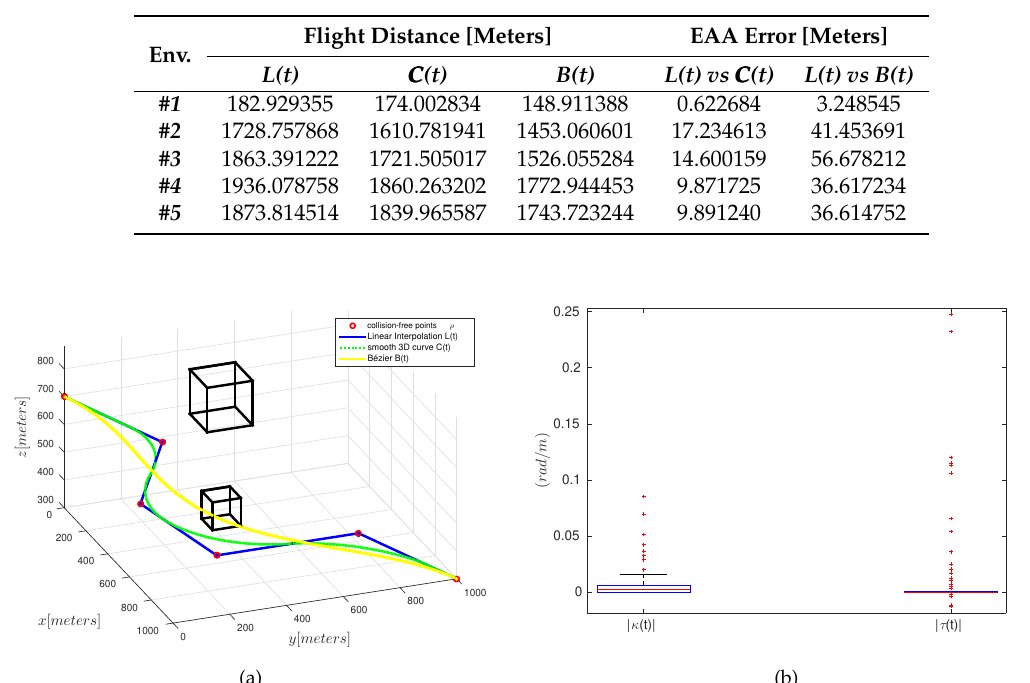
Figure 8. Example of a 3D environment cluttered of obstacles. ( a ) Reconstruction of 3D trajectories, where the obstacles are the black boxes; the red circles show the collision-free points; and the green line shows the final 3D trajectory CCC ( t ) . The yellow line represents the Bézier B ( t ) curve. ( b ) Geometric averages of the variables κ and τ of the final path.